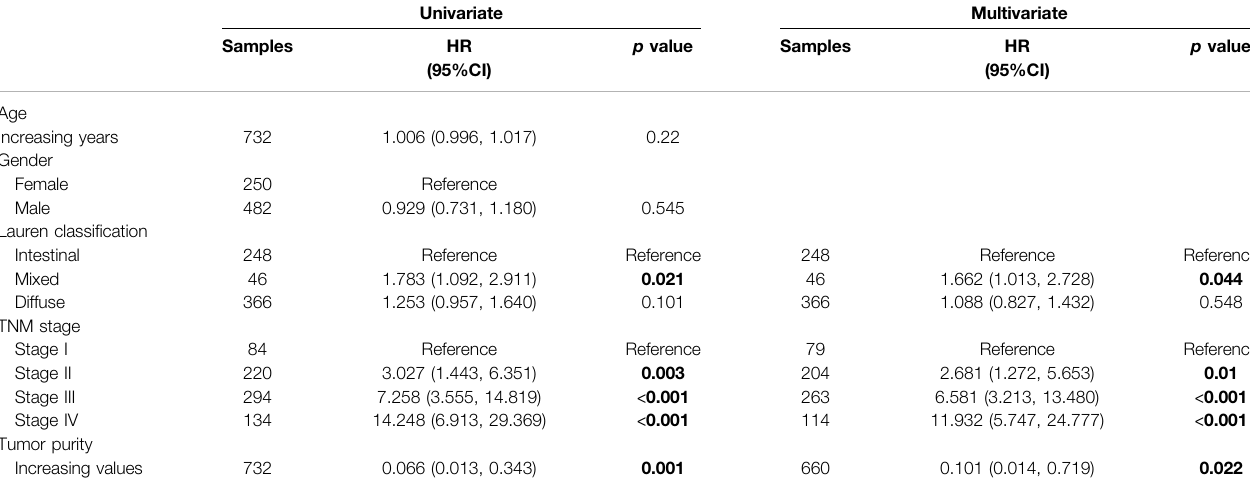
TABLE 4 | Univariate and multivariate cox analyses for tumor purity in patients who received adjuvant